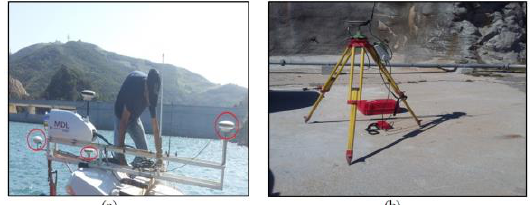
Figure 3. Positioning equipment: (a) GNSS receivers in RTK mode (b) GNSS receiver on the fixed